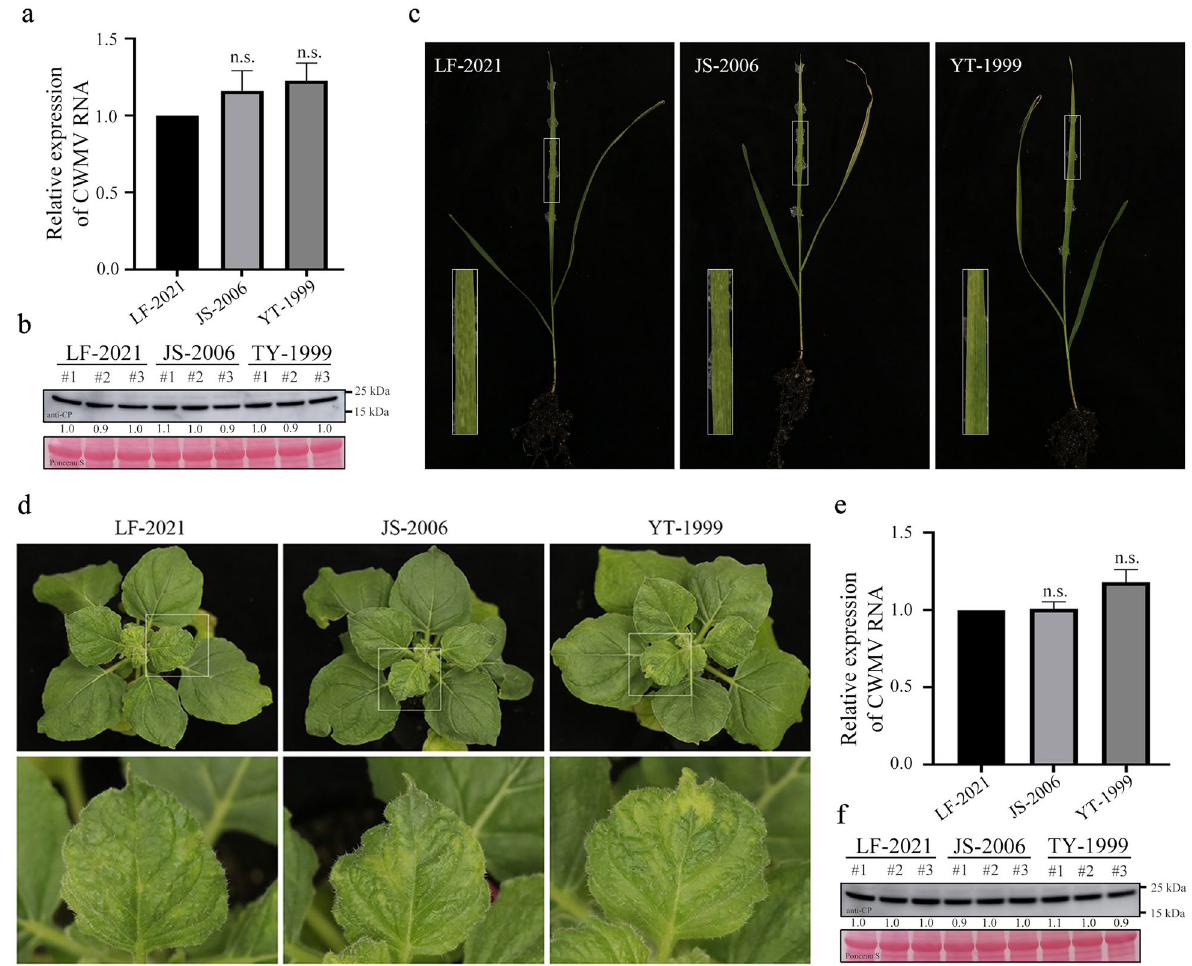
Fig. 5 The function of natural variation of coat protein (CP) from different CWMV isolates on CWMV infection. a, b The accumulation of CWMV RNA ( a ) and protein ( b ) in the systemic leaves of wheat plants inoculated with LF-2021, JS-2006, or YT-1999 at 28 dpi. LF-2021, JS-2006, and YT-1999 represent of the CWMV infectious clones containing CP from a previous isolate Langfang-2021, Jiangsu-2006, and Yantai-1999_1, respectively. The values were normalized to those for the reference gene ( TaCDC ) and are presented as fold changes in expression relative to that in wheat leaves inoculated with LF-2021, JS-2006, and YT-1999. Asterisks indicate significant differences in expression between wheat leaves inoculated with JS-2006 and LF-2021 when analyzed using a Student’s t -test ( P < 0.05). The CWMV protein accumulation was determined by estern blot using CP specific antibody. c The phenotype of wheat plants inoculated with JS-2006 and LF-2021 at 40 days post-infiltration (dpi). d Systemic mosaic symptoms in systemic leaves of Nicotiana benthamiana plants infected with JS-2006 and LF-2021 at 40 dpi. e Relative expression level of CWMV CP in the systemic leaves of N. benthamiana plants infected with LF-2021, JS-2006, and YT-1999. Values and error bars represent the mean independent biological replicates with three technical replicates per sample, *, P < 0.05 based on Student’s t -test. f Western blot analysis of CWMV CP accumulation in the systemic leaves of N. benthamiana plants infected with LF-2021, JS-2006, and YT-1999 using CWMV CP specific